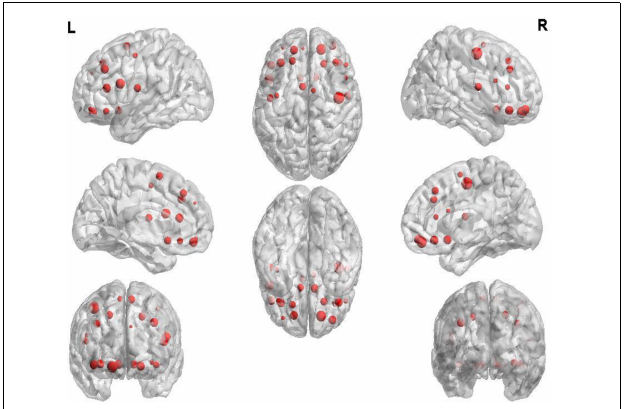
FIGURE 5 | The weight of brain regions.